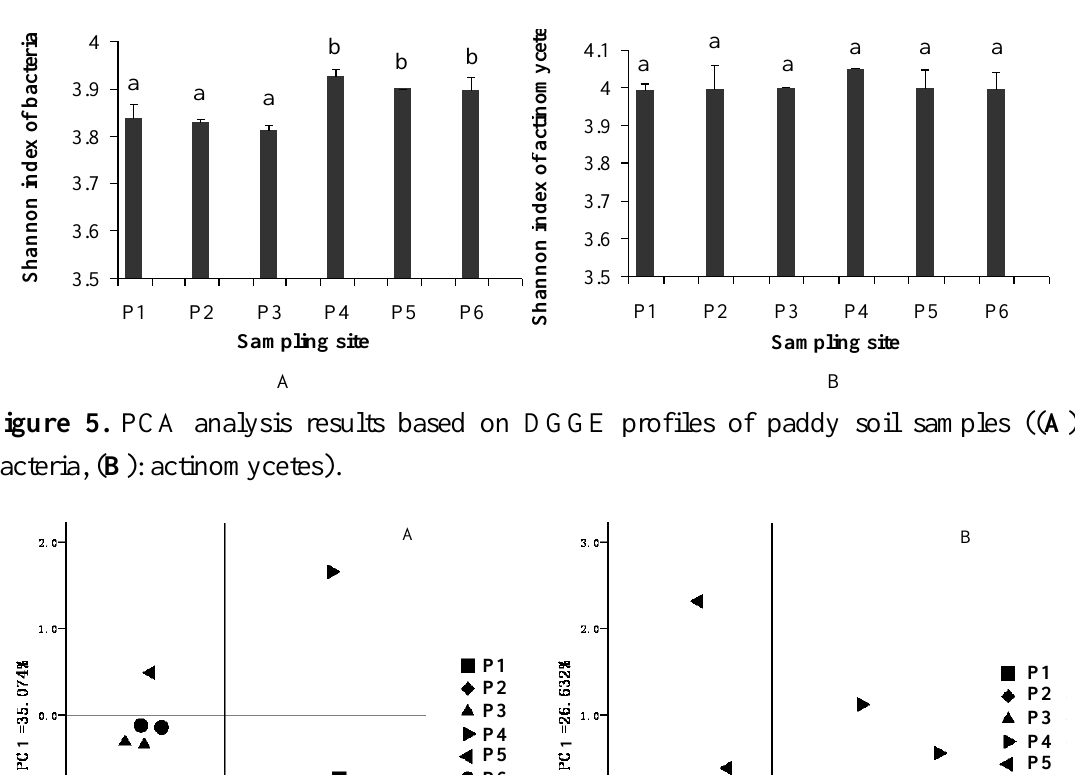
Figure 4. Shannon diversity indexes of bacteria ( A ) and actinomycetes ( B ) in different soil samples. (Different letters in the column indicated significant difference, p ≤ 0.05).